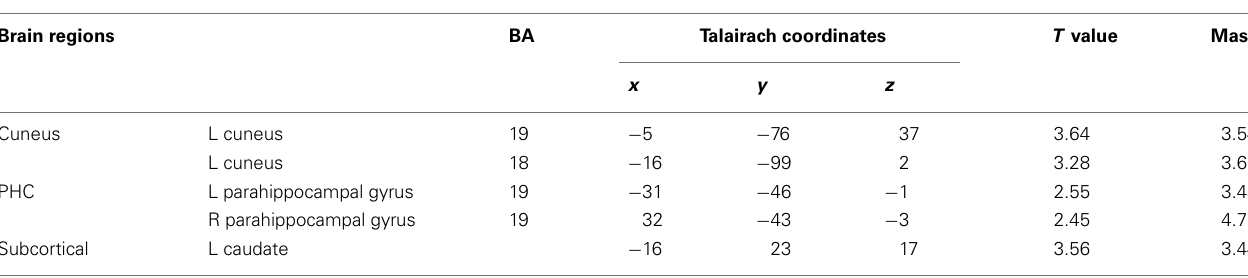
The table identifies brain regions mediating both the WM impairing and EM enhancing effects of emotion by contrasting emotional (Emo) and neutral (Neu) items that impairedWM and were later remembered (WM-F and EM-R). Effects in the ventral affective (EmoWM-F and EM-R > NeuWM-F and EM-R) and dorsal executive (Neu WM-F and EM-R > Emo WM-F and EM-R) networks were masked by their corresponding a priori ROIs (i.e., Emo > Scr in the ventral and Scr > Emo in the dorsal networks, respectively; see Materials and Methods). mPFC, medial prefrontal cortex; vlPFC, ventrolateral prefrontal cortex; latPFC, lateral prefrontal cortex; MFC, medial frontal cortex; PrCG, precentral gyrus;TOC, temporal-occipital cortex; MTL, medial-temporal lobe; dlPFC, dorsolateral prefrontal cortex; PCL, paracentral lobule; LTC, lateral temporal cortex; SPL, superior parietal lobule;TPC, temporal-parietal cortex; PHC, parahippocampal cortex. Significance thresholds are p < 0.05 for the effects of emotion and p < 0.005 for the a priori masks.